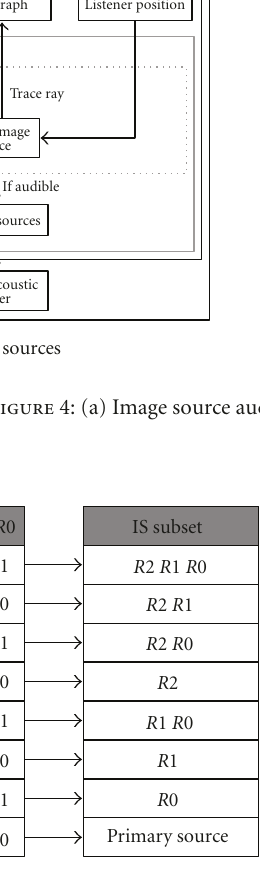
Figure 5: IS/room-combination-power set P ( S ) for a three-room situation. All IS are sorted into encapsulated containers depending on the room combination they have been generated